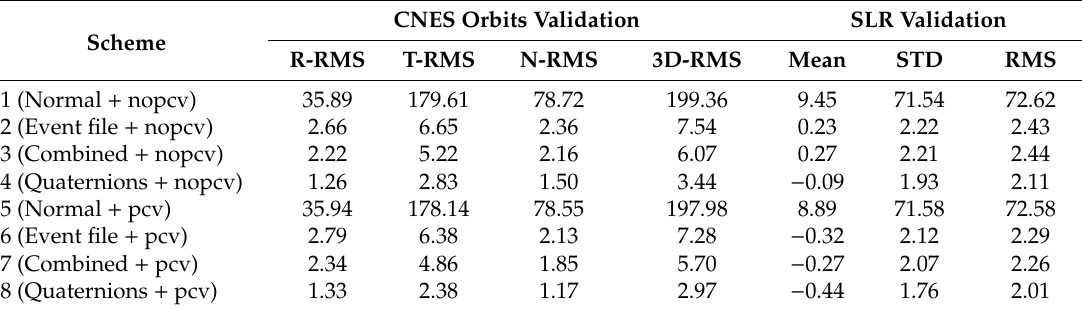
Table 5. Accuracy comparison of eight POD schemes [unit: